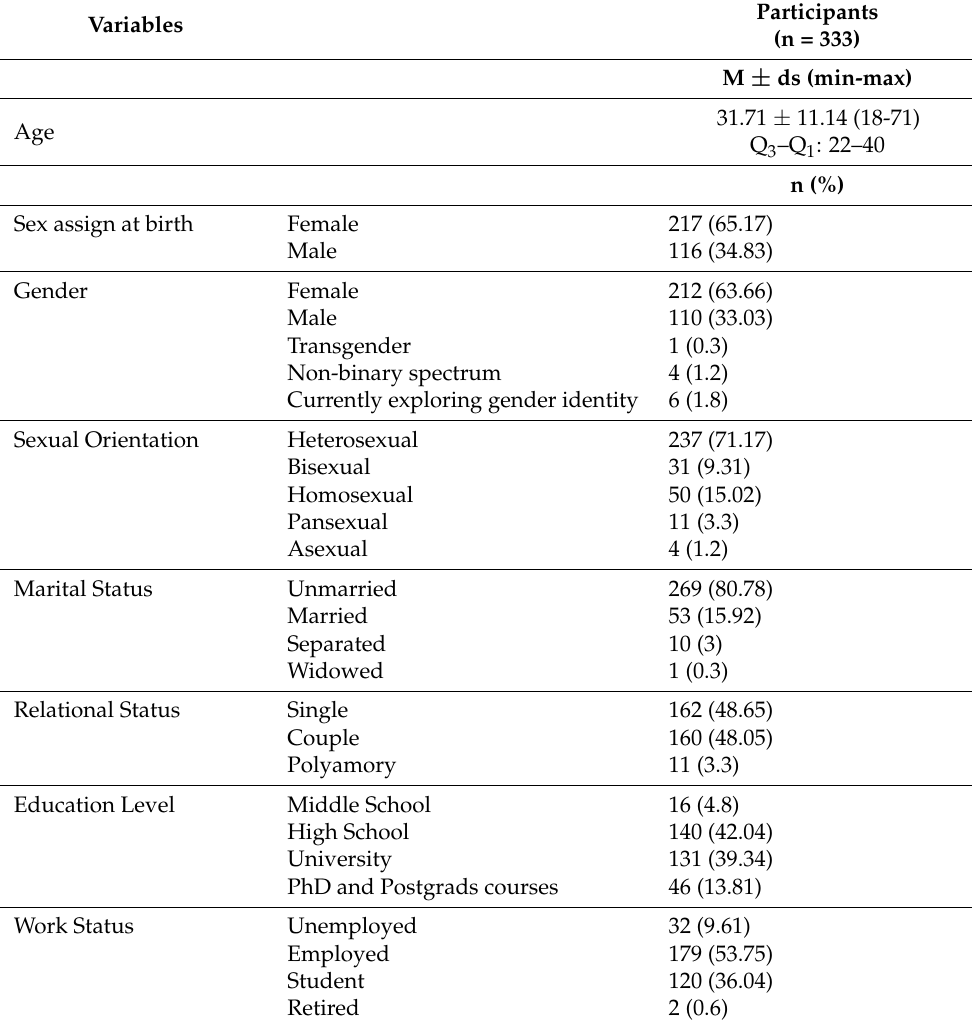
Table 1. Sociodemographic variables